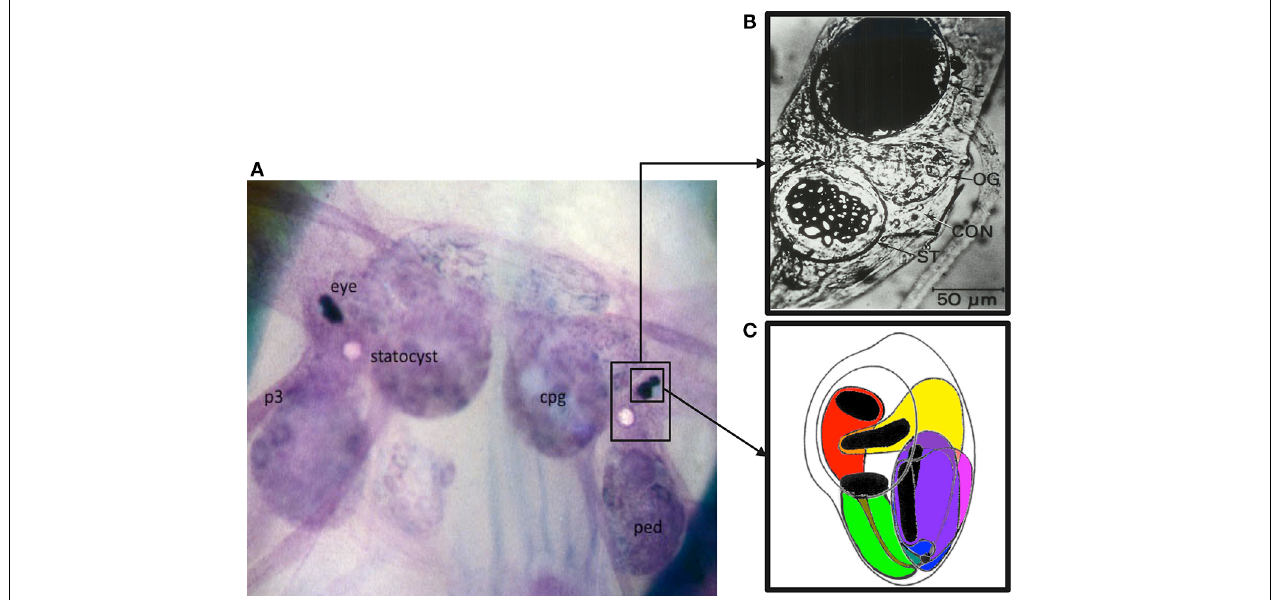
FIGURE 1 | The Hermissenda ( H.c. ) circumesophageal nervous system (CNS): entire CNS, eye, and statocyst. (A) Low resolution macrophotograph of an in situ toluidine-blue stained CNS. Note that the eye and statocyst lie on the dorsal surface of the CNS, in between the cerebropleural (cpg) and pedal (ped) ganglia. Pedal nerves (e.g., p3) project from the pedal ganglia down to the pedal musculature. (B) Photomicrograph of a H.c. eye (top, dark structure) and statocyst (bottom, ST, crystalline structure). Non-excitable, and non-photoresponsive pigmented cells are responsible for the black appearance of the eye, and obscure the photoreceptors. Portions of the photoreceptors are visible along the bottom of the eye. (C) Schematic drawing of a right eye, illustrating the relative positions of the three Type B photoreceptors (medial, intermediate, and lateral, colored here as green, purple, and magenta, respectively) and the two Type A photoreceptors (medial and lateral, colored here as red and yellow, respectively). Note the black rhabdomeric portions of the photoreceptors, where phototransduction occurs. The rhabdomeres are oriented toward the lens. Note also that each photoreceptor has an axo-dendritic process extending from its base. The one extending from the (red) medial